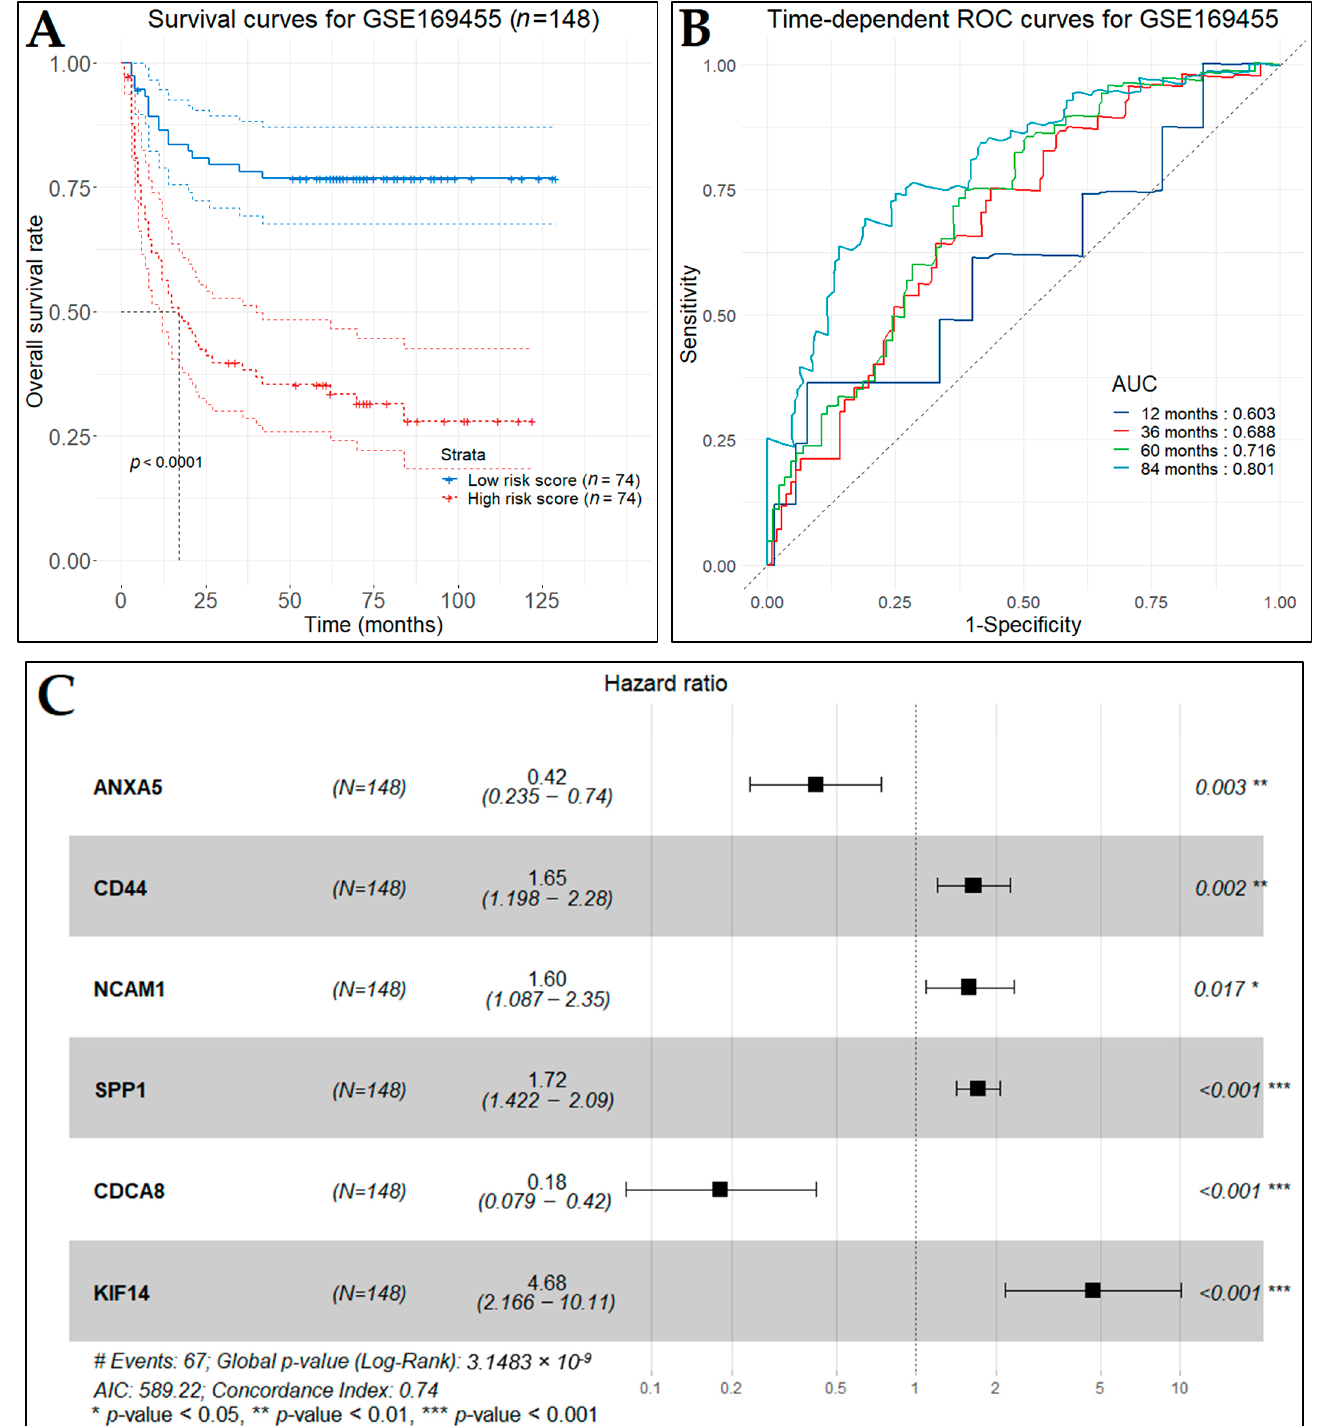
Figure 21. Survival analysis for the GSE169455 ( n = 148) dataset (training set). ( A ) Kaplan–Meier curves for disease-free survival of MIBC patients who received cisplatin-based chemotherapy as stratified by the six-gene predictive index. Patients were divided into low- and high-risk groups according to the median predictive index. ( B ) Time-dependent ROC curves (one-, three-, five-, and 10-year predictions) to assess the predictive accuracy of the six-gene predictive model. ( C ) Forest plot for multivariate Cox regression analysis on the GSE169455. The figure incorporates the hazard ratio value (e coef ) along with the 95% CI and p -value for each gene.